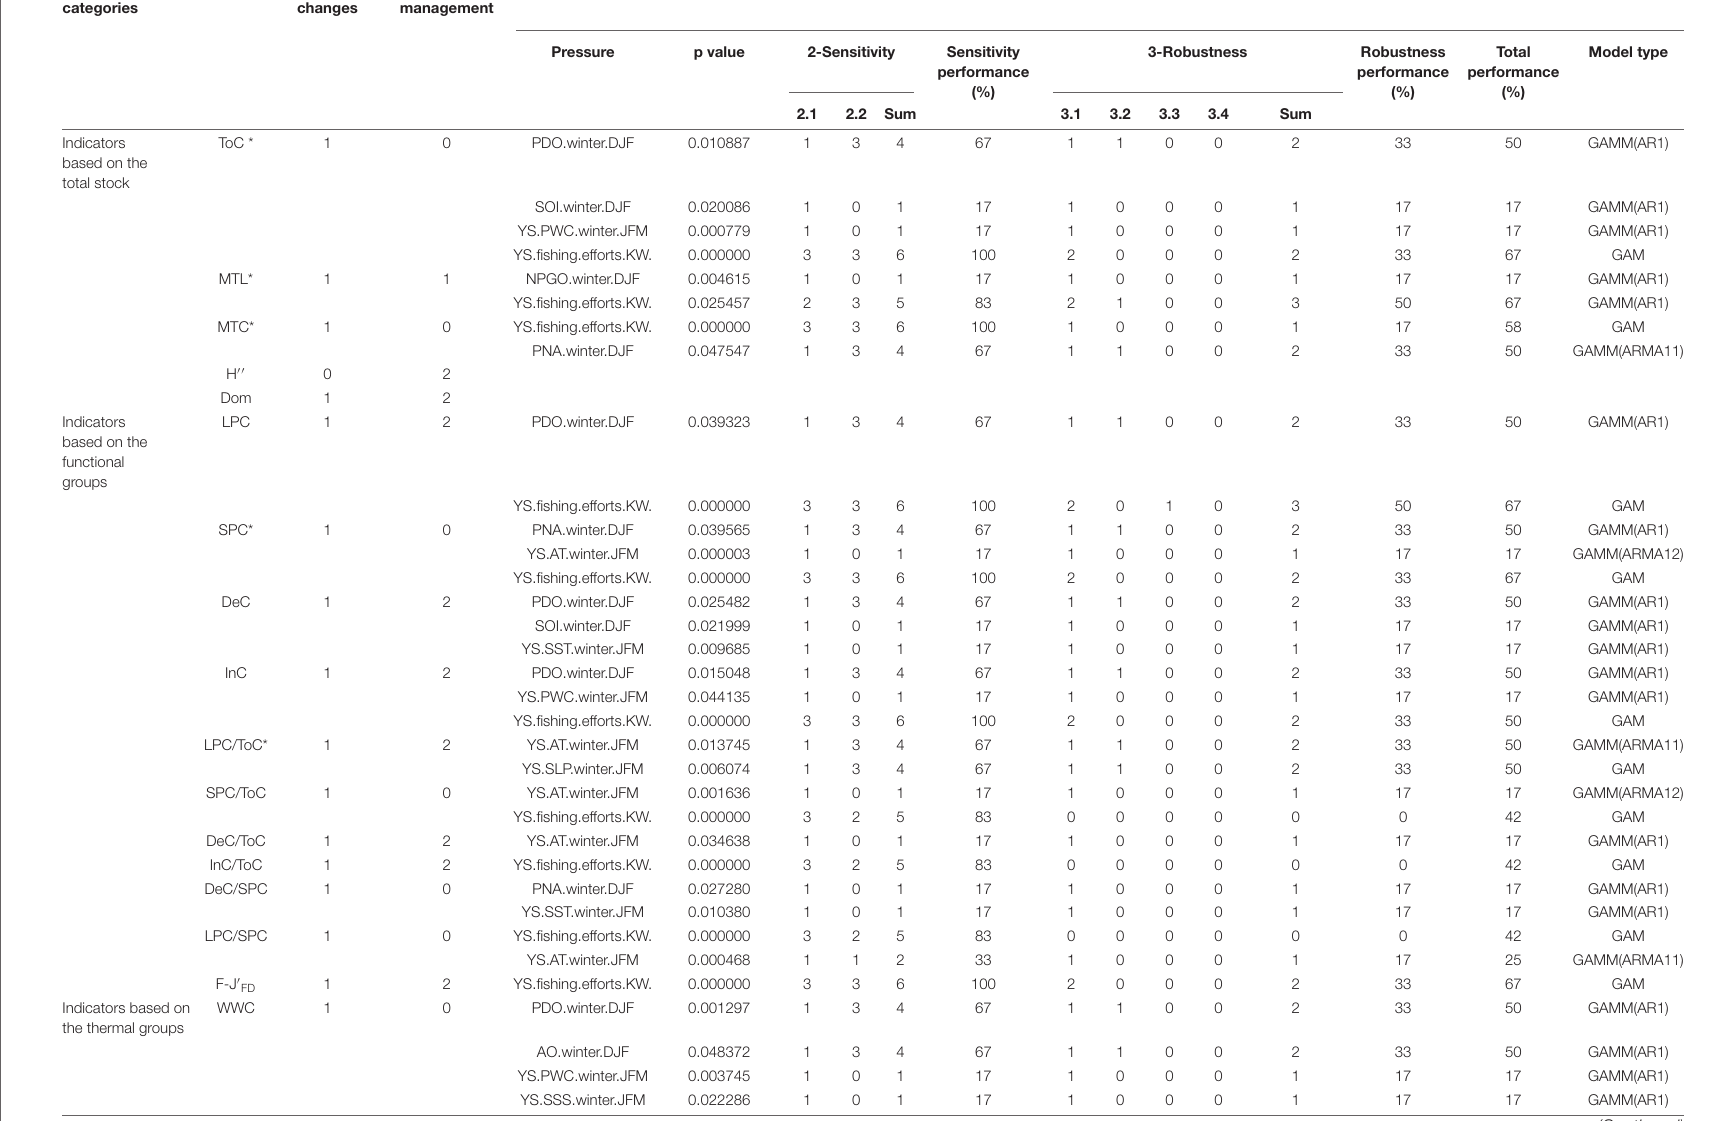
TABLE 2 | Overview of performance scores of fishery ecosystem structure indicators for each criterion in the YS. IFCS